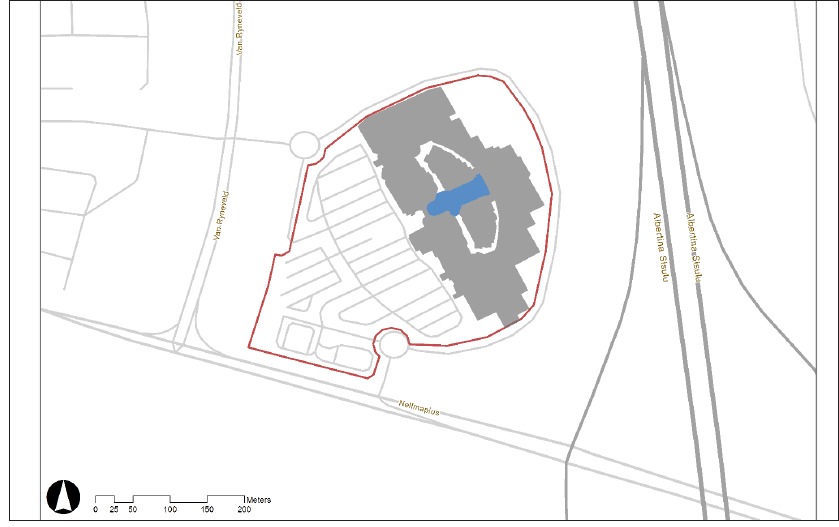
Figure 8: The form and location of the quasi-public space in Irene Village Mall Source: Produced by Darren Nel,